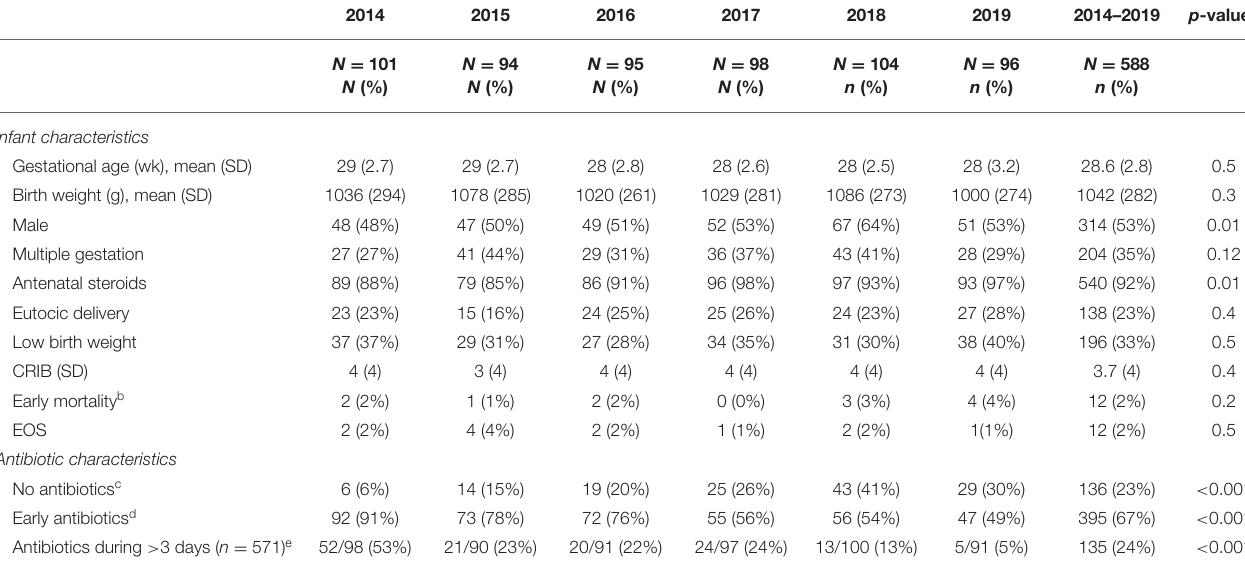
TABLE 1 | Infant and antibiotic characteristics of VLBW ( < 1500g), 2014 to